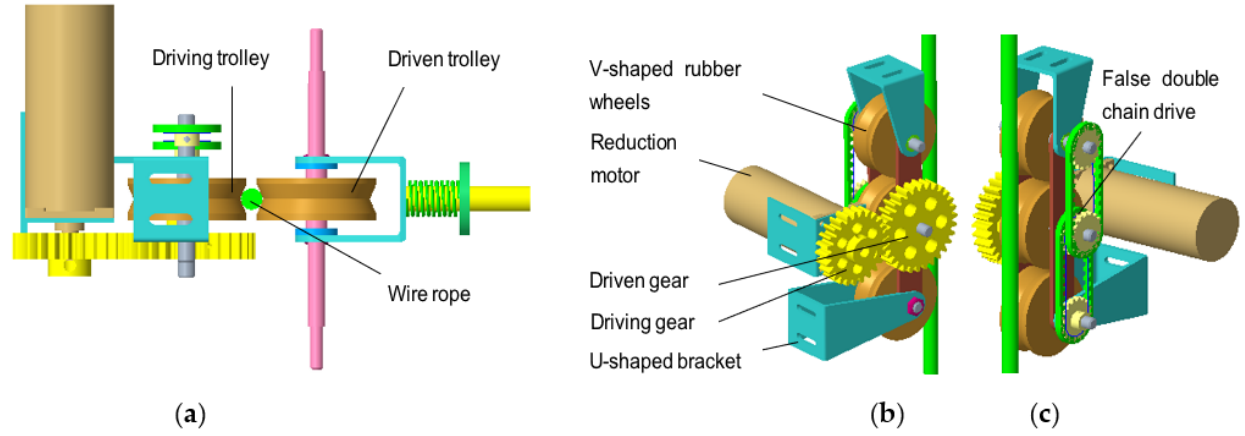
Figure 4. The 3D CAD structure of the locomotion device. ( a ) The top view of the mobile device, ( b ) the front structure of the driving trolley, and ( c ) the back structure of the driving trolley.